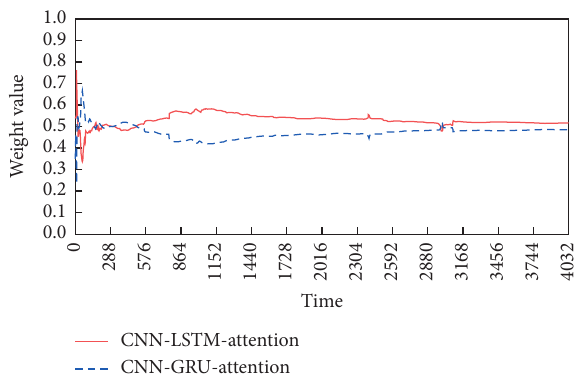
Figure 9: Dynamic weight value of CNN-LSTM-attention and CNN-GRU-attention